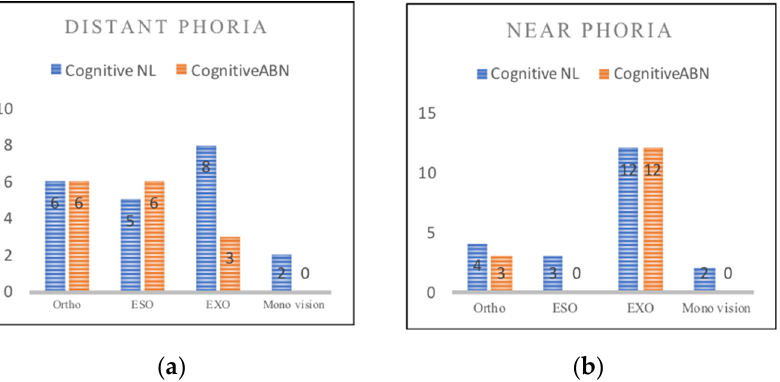
Figure 3. ( a ) Distant phoria in normal (NL) and abnormal (ABN) subjects. ( b ) Near phoria in normal (NL) and abnormal (ABN)